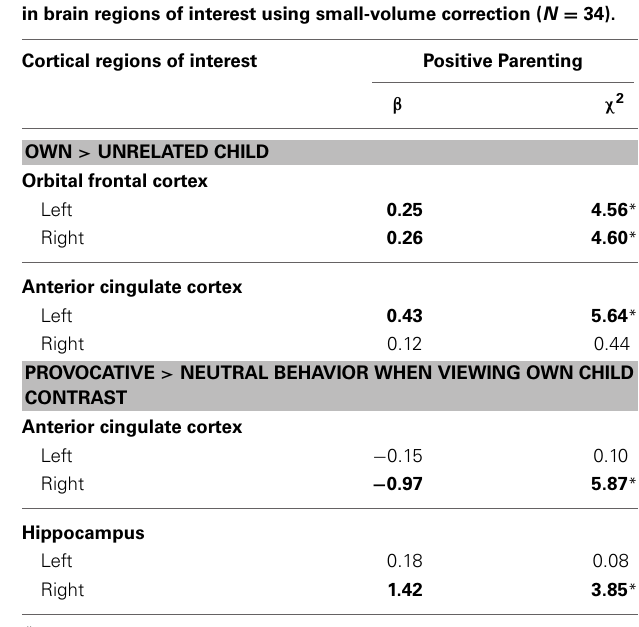
Simultaneous covariates: Child’s age in years, child’s sex, African American ancestry, child’s ADHD diagnosis, child’s disruptive behavior during mother-child interaction task, first born status, mother’s number of live births, prematurity in weeks, Caesarian delivery, and mother’s age at scanning.